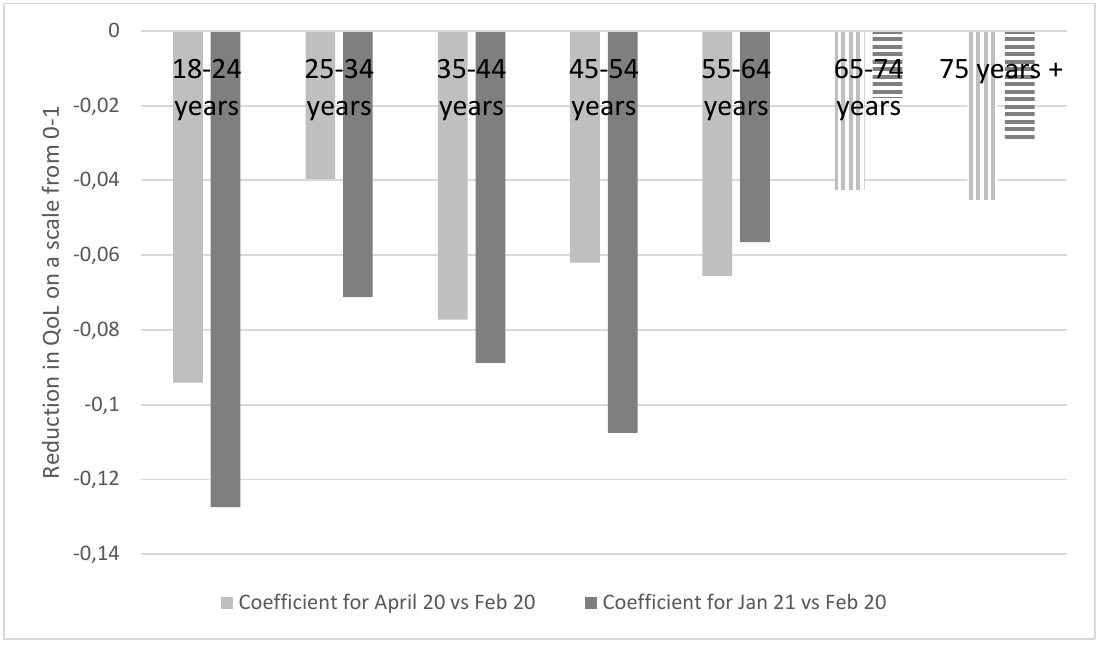
Figure 2: Reduction in QoL based on pooled VAS regression by age (horizontally striped bars indicate no significant change, vertically striped bars indicate significant at p<0.1, all other changes significant at